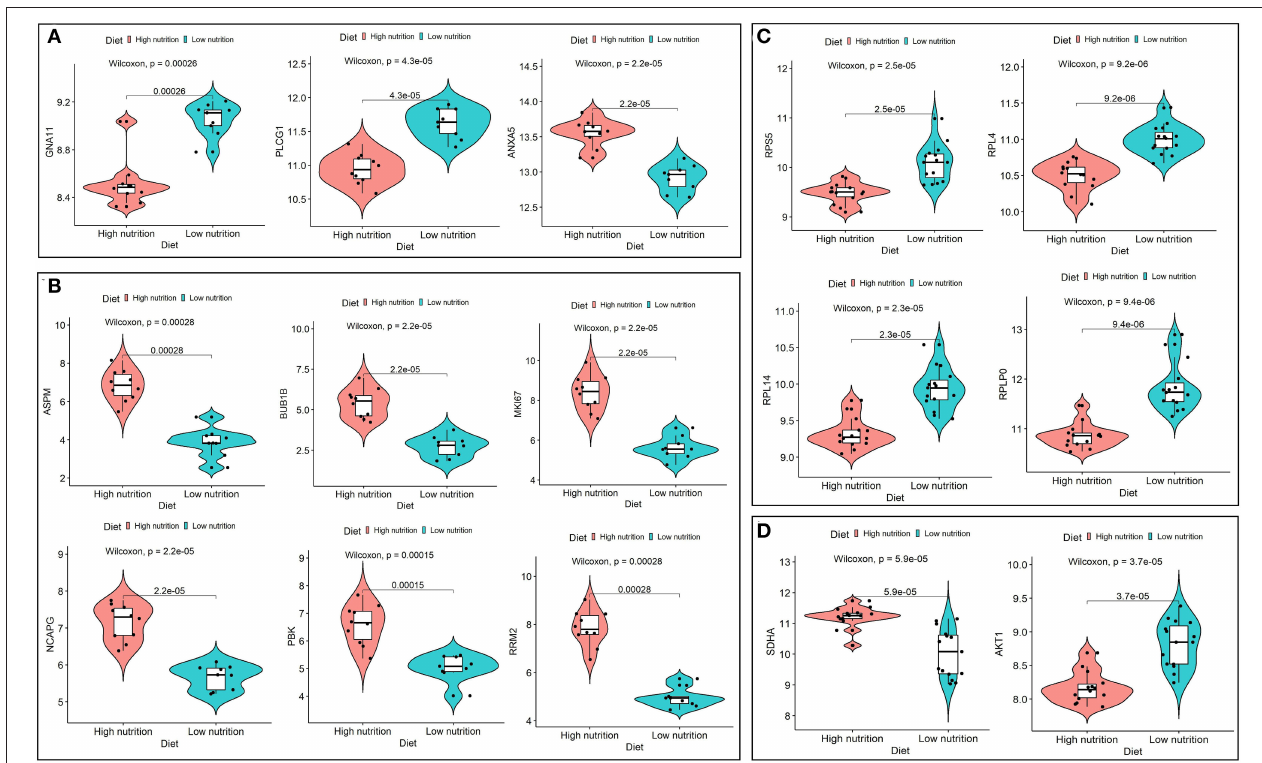
FIGURE 8 | Expression analysis of hub genes under high and low levels of nutrition. Expression levels of hub genes for low nutrition (A) , and high nutrition (B) in subcutaneous adipose tissue, and hub genes for low nutrition (C) , and high nutrition (D) in visceral adipose tissue.